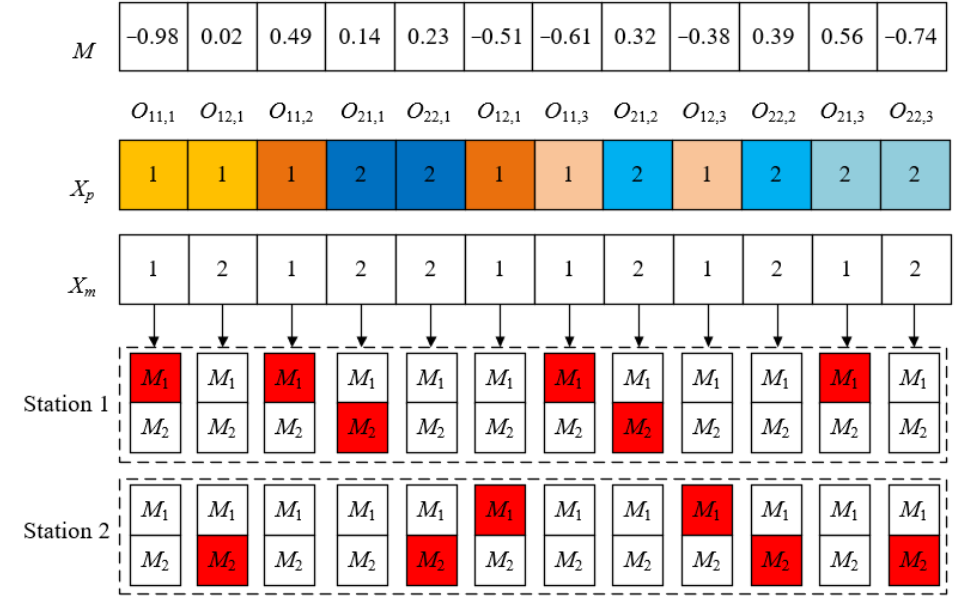
Figure 3. Encoding and decoding schematic.